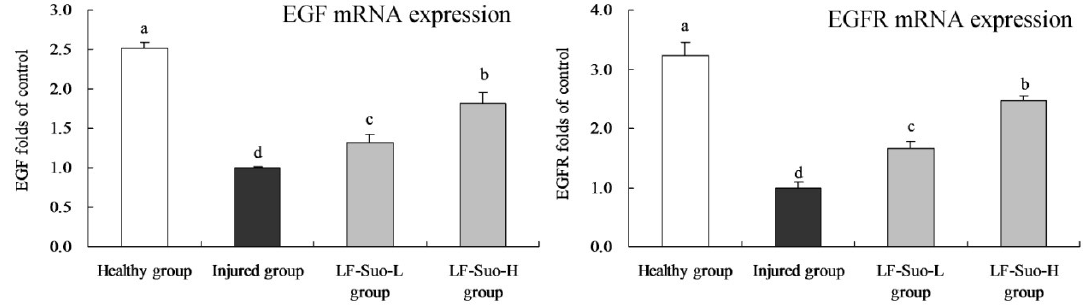
Figure 3. EGF and EGFR mRNA expression of studied mice. Fold ‐ ratio: gene expression/GAPDH × injured group numerical value (injured group fold ratio: 1). a–d Mean values with different letters in the same column are significantly different ( p < 0.05) according to Duncan’s multiple ‐ range test. LF ‐ Suo ‐ L, Lactobacillus fermentum Suo (0.5 × 10 9 CFU/kg b.w.); LF ‐ Suo ‐ H, Lactobacillus fermentum Suo (1.0 × 10 9 CFU/kg b.w.).